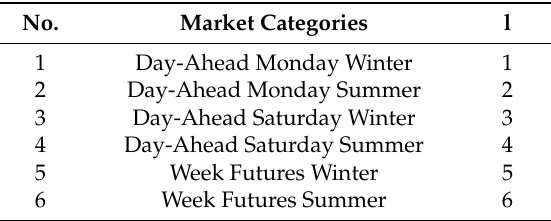
Table A5. Market